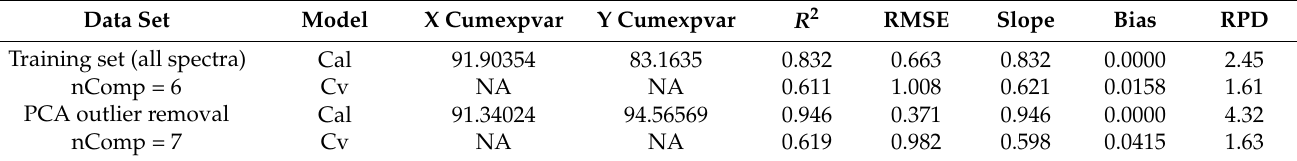
Table 4. PLS model (class pls) summary for the TSS